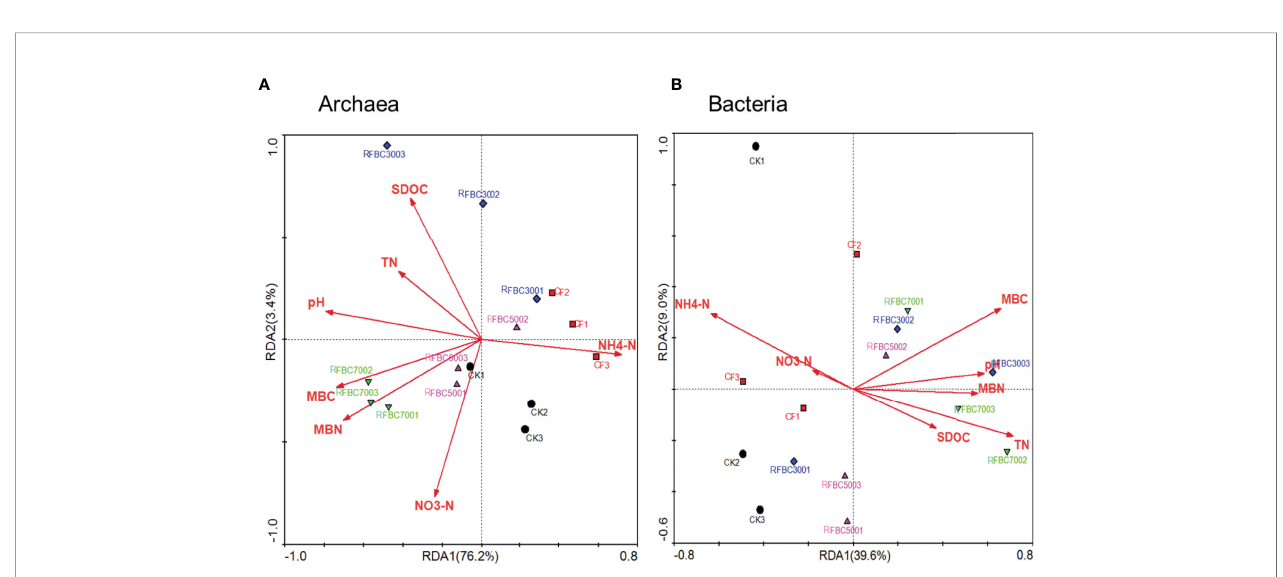
FIGURE 6 | Redundancy analysis (RDA) of archaeal (A) and bacterial (B) community composition at class level in soil samples collected after 55 days column leaching of paddy soil incorporated with or without biochar amendments and/or fertilizer (i.e. CK: Control treatment without biochar and fertilizer; F: Only fertilizer added; FBC300: 300°C biochar combined with fertilizer; FBC500: 500°C biochar combined with fertilizer; FBC700: 700°C biochar combined with